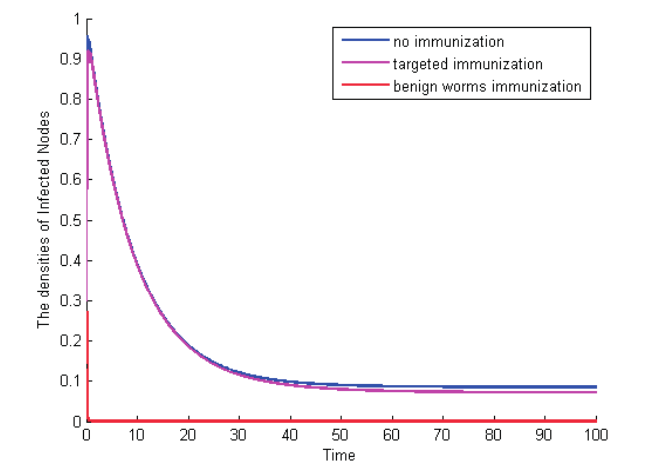
Figure 6. The average densities of malicious infected nodes for different immunization